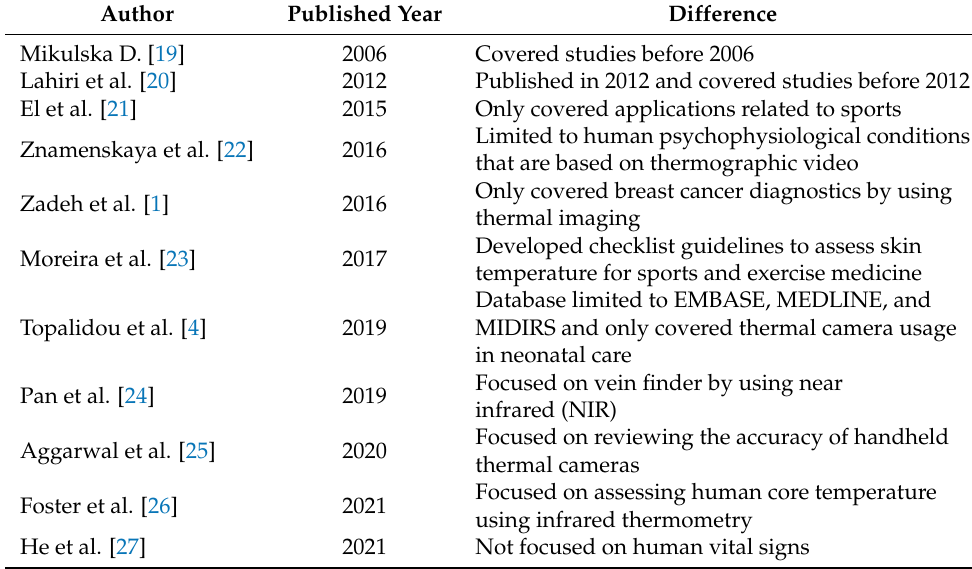
Table 1. Existing Systematic